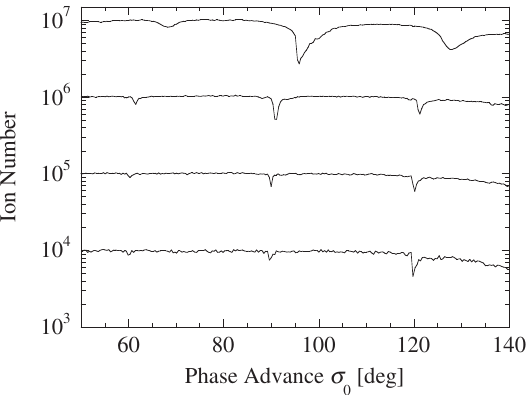
FIG. 7. Ion-loss distributions measured in S-POD with the symmetric FODO potential where ξ ¼ 0 . 5 and ζ ¼ 1 . The experimental condition is the same as adopted in Fig. 6 except ð τ Þ for the rf focusing waveform of K rf